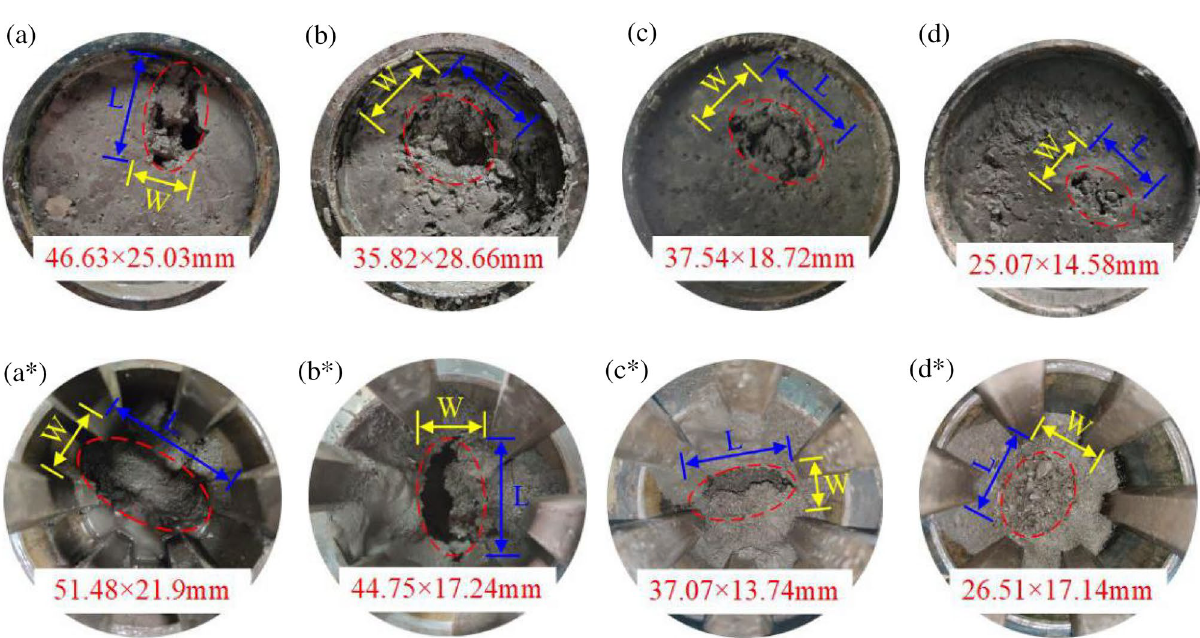
Figure 9. Bottom failure area and top water inrush channel of the samples at each